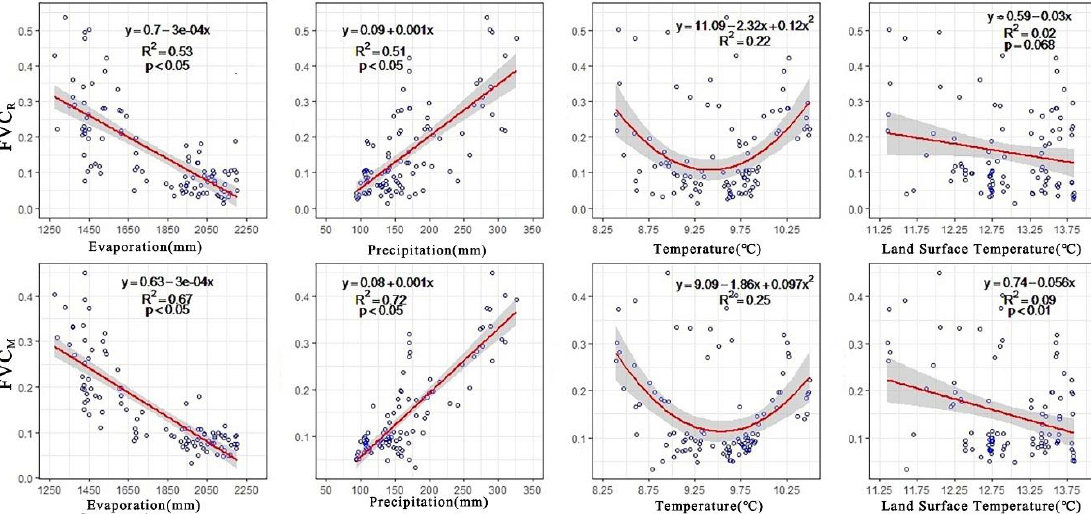
Figure 9. Relationship between FVC and meteorological factors.